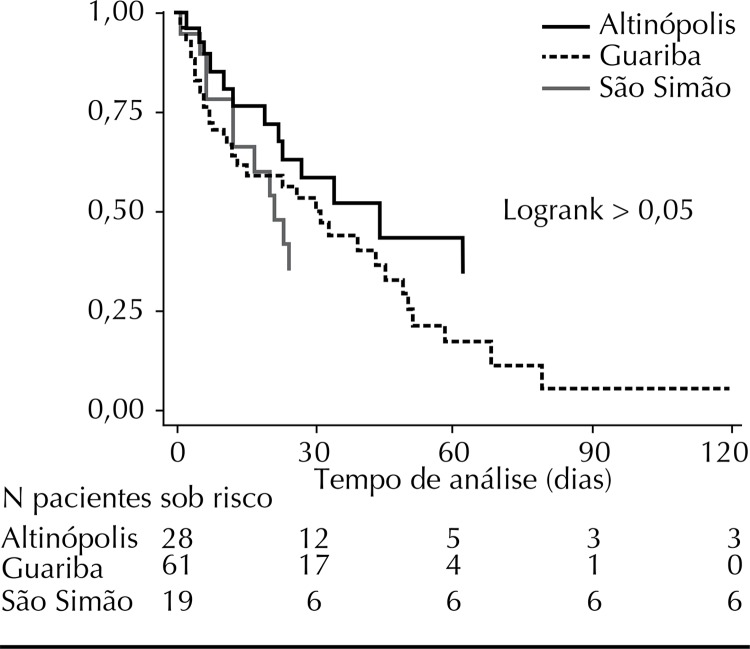
Gráfico de Kaplan-Meier para o tempo de permanência de pacientes em cada instituição.